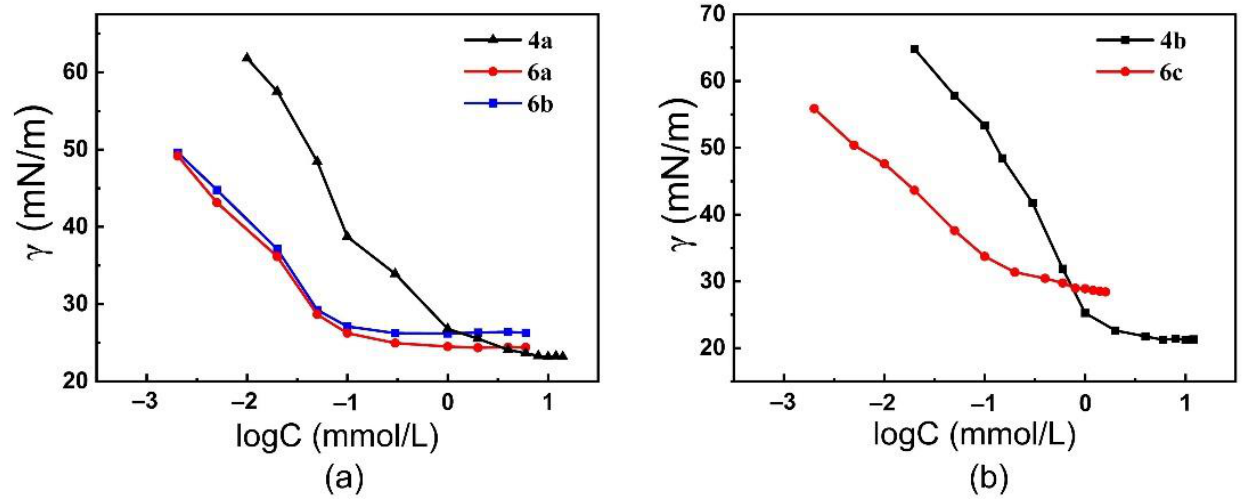
Figure 4. Concentration dependence of static surface tension of ( a ) 4a , 6a , and 6b and ( b ) 4b and 6c . Table 2. Values of CMC, γ min , Г max, A min , and p C 20 for the surfactants.